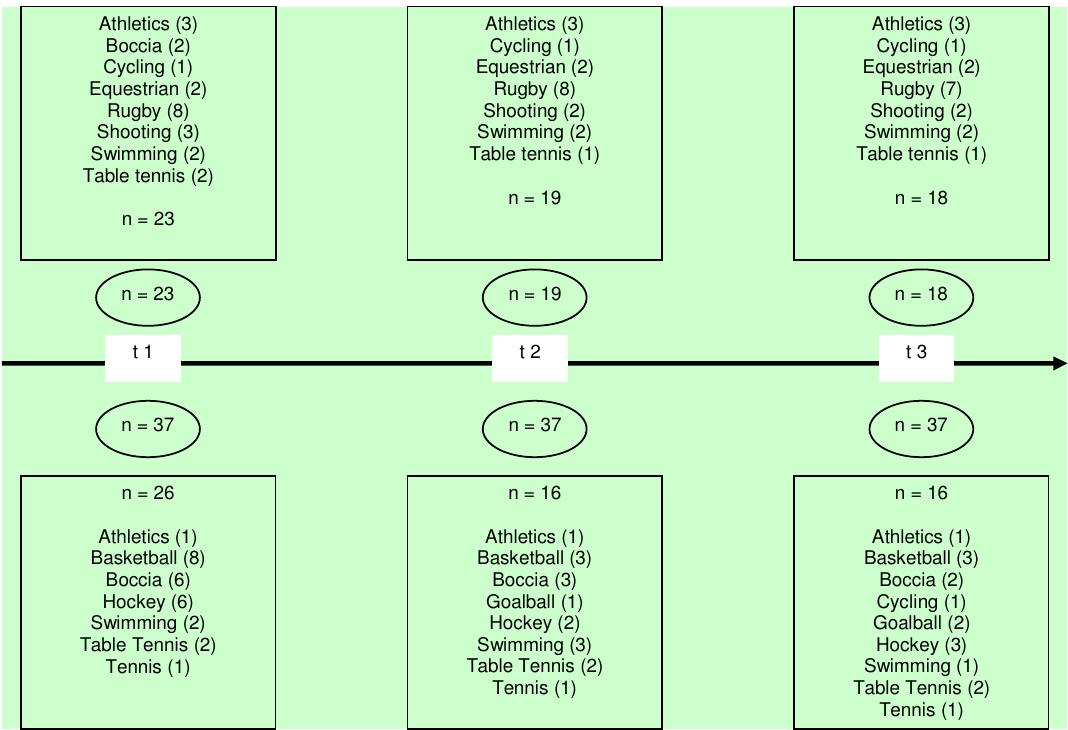
Flow chart of participant characteristics over the duration of the investigation [time 1 = 11 months prior to 2004 Athens Paralympic Games (APG); time 2 = 2 months prior to 2004 APG; time 3 = 1 month after the 2004 APG] (upper part = Paralympic Athletes; bottom part = Non-Paralympic Elite Athletes; in circles = total sample invited to participate; in box = respondent